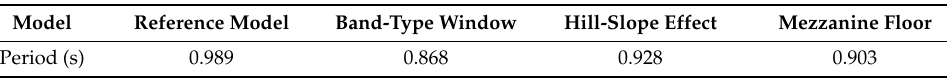
Table 3. The periods of the structural models.